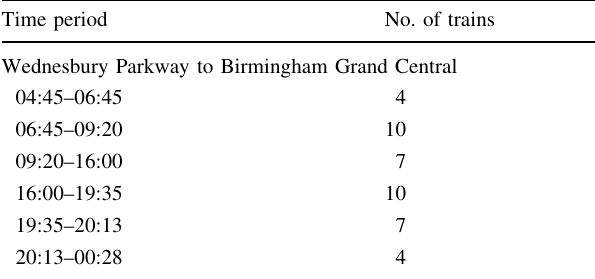
Table 3 No. of services from Wolverhampton St. George’s to Birmingham Grand Central (section 3) Time period